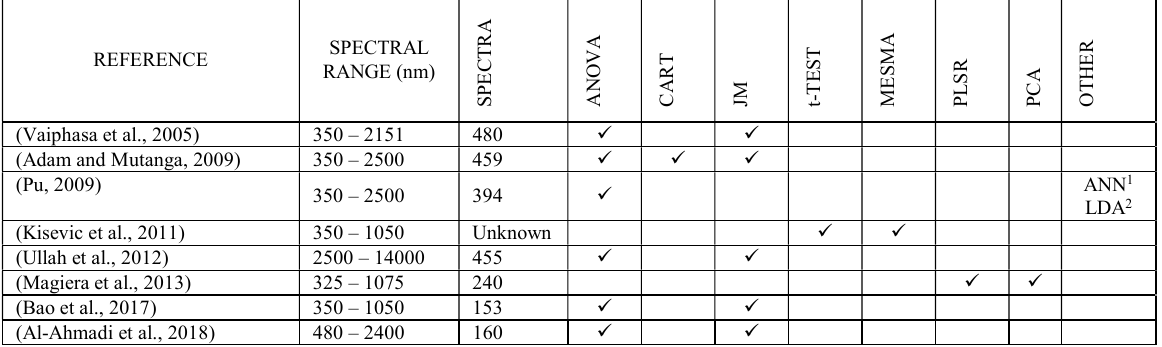
1 Artificial Neural Network 2 Linear Discriminant